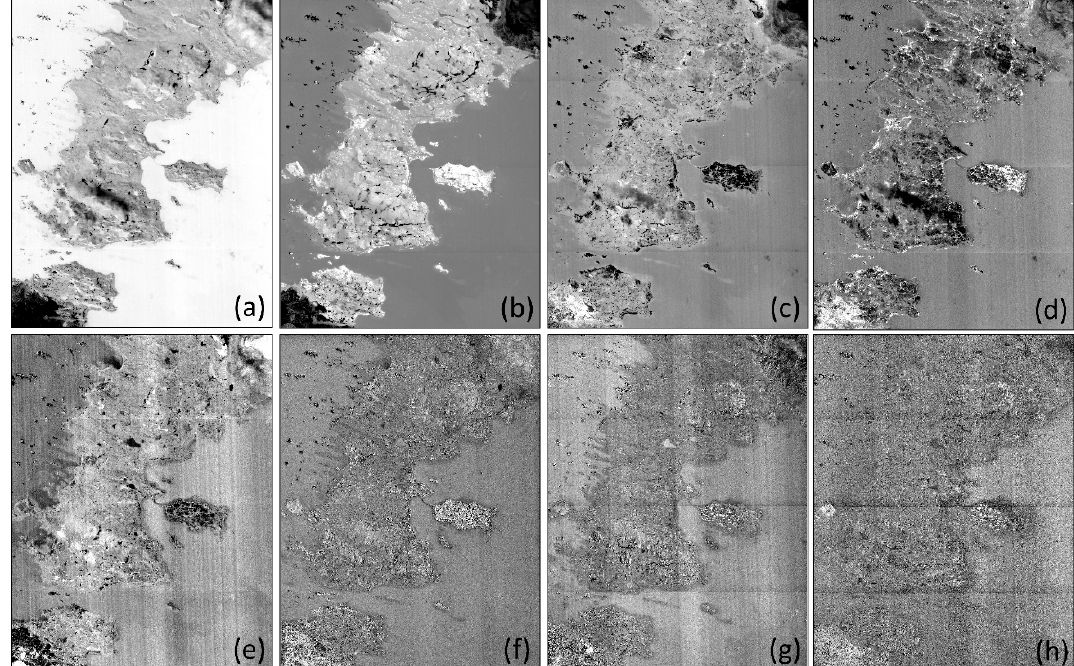
Figure A1. Results of minimum noise fraction (MNF) transformation. ( a )–( h ) are the principal component bands of 1–8.